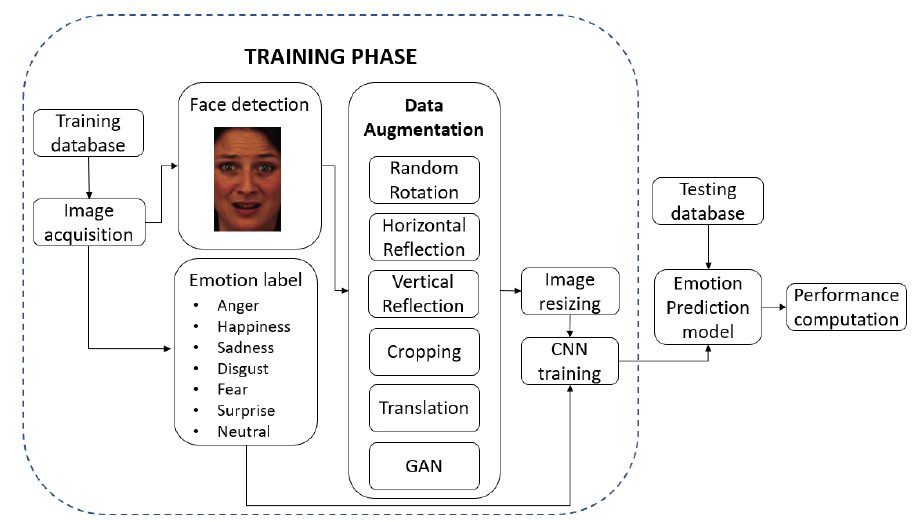
Figure 1. The proposed FER system. The dashed line separates the training phase from the testing